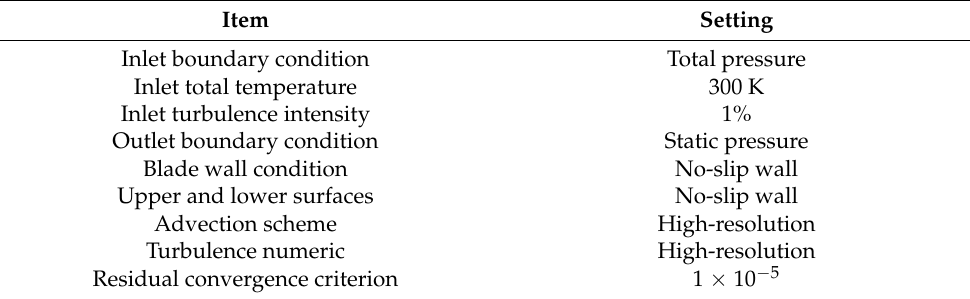
Figure 7. Boundary conditions of the computational domain. Table 4. Numerical calculation settings.